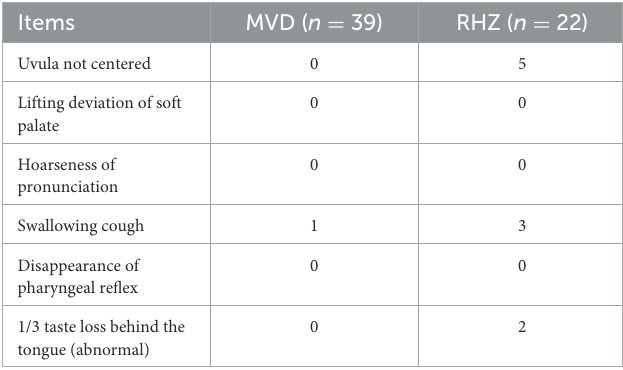
TABLE 4 On the 14th day after operation, the cranial nerve functions of the IX, X and Xi groups were examined. Items MVD ( n = 39) RHZ ( n = 22) Uvula not centered 0 Lifting deviation of soft